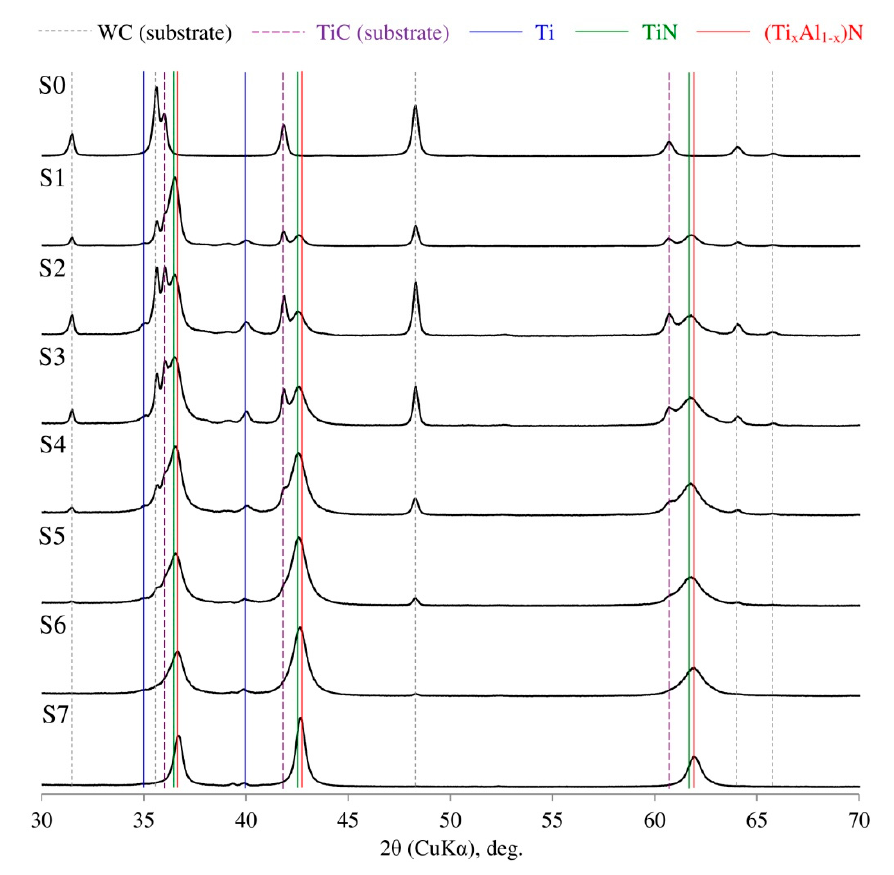
Figure 11. The XRD patterns of investigated coatings: S1–S7 substrate and coating; S0 substrate (WC–Co).